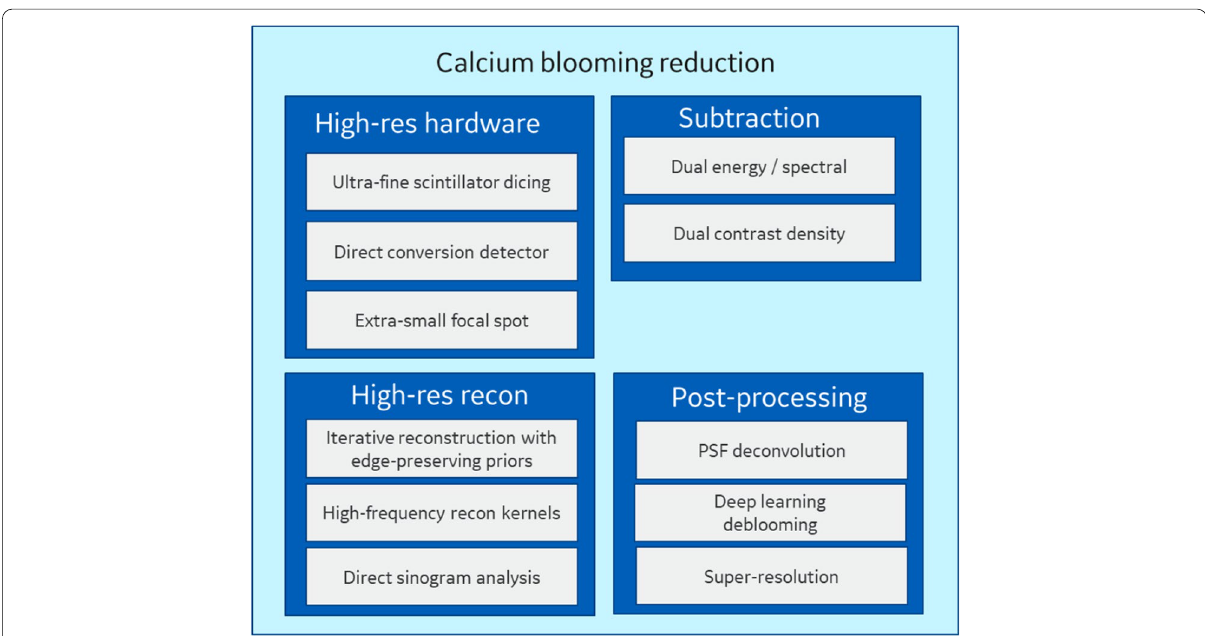
Fig. 8 A diagram illustrating various technical approaches for mitigating the primary cause of calcium blooming: partial volume